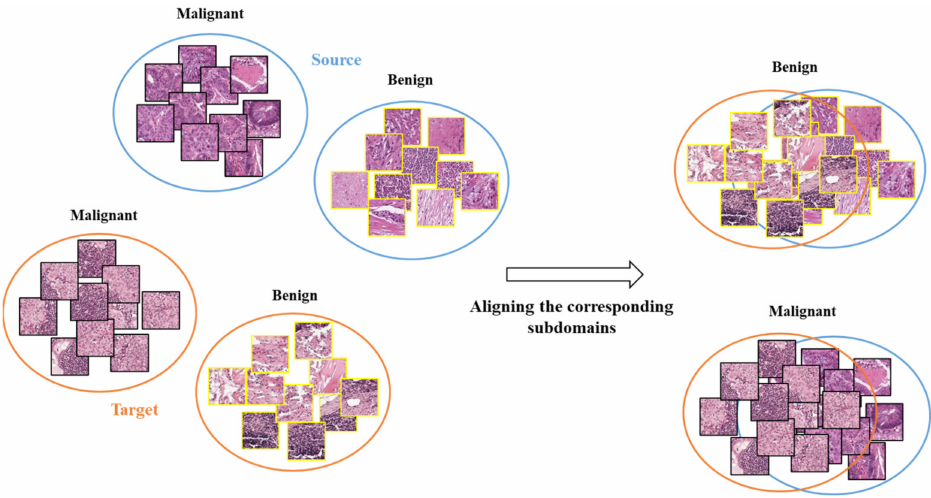
Figure 3. The schematic diagram for illustrating subdomain